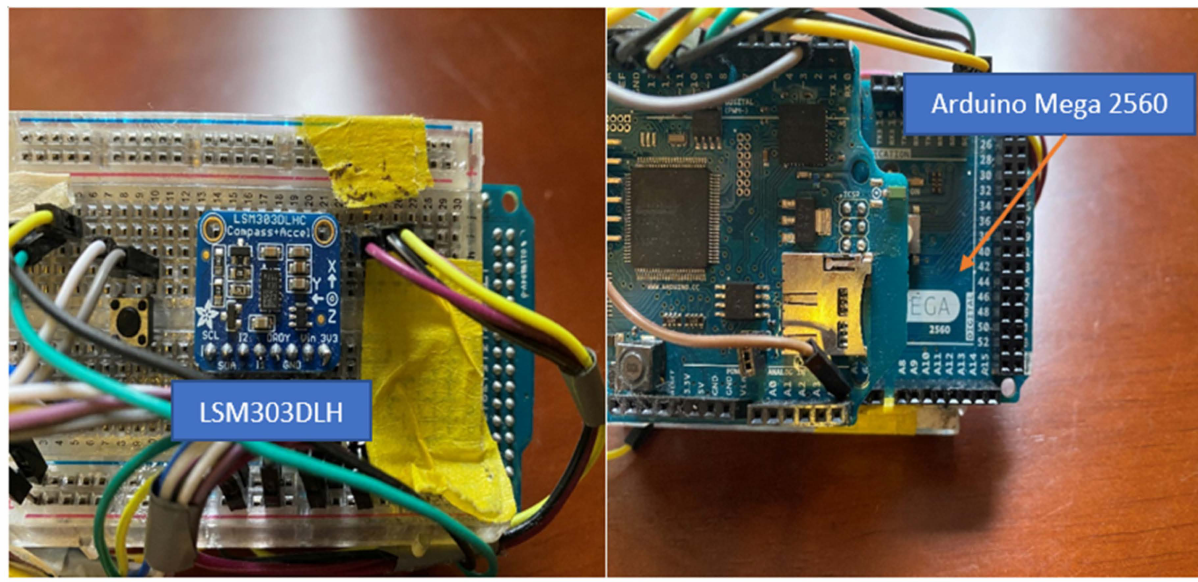
Figure 2. Experimental setting—LSM 303DLHC